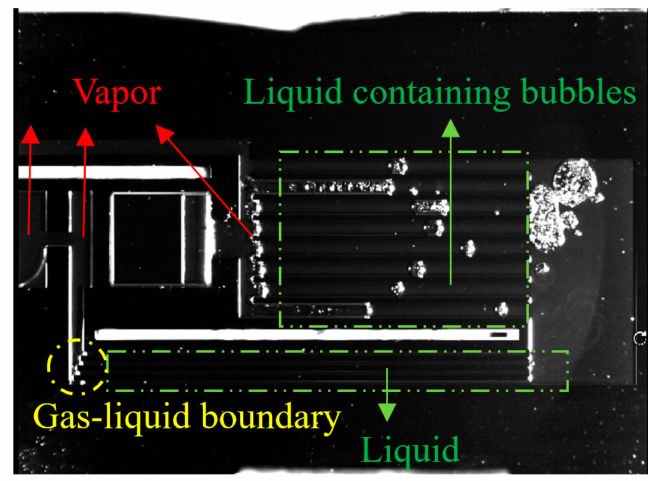
Figure 13. Imaging of s-UTLHP during